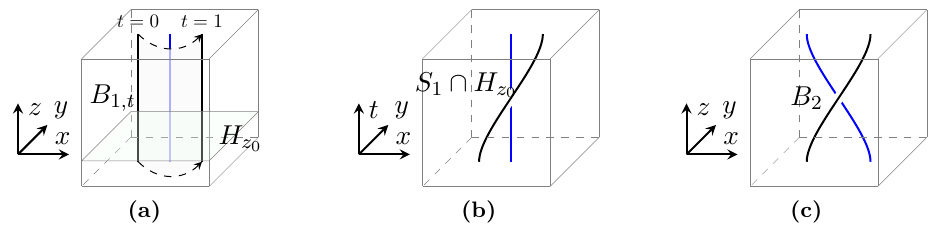
Figure 3. (a): the time slice of the world sheet S 1 of braiding two strings at time t is B 1 ,t ; (b): the section of S 1 at z = z 0 is a braid B 0 is isotopic to B 2 .